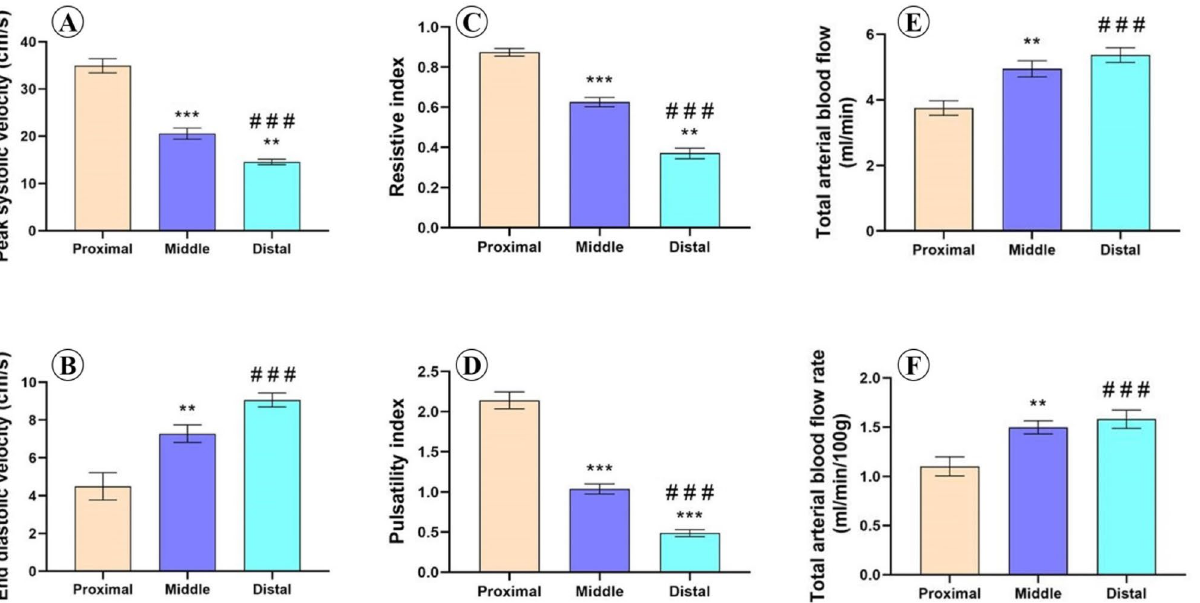
Figure 3. Doppler parameters measured in proximal, middle and distal supratesticular zones in the supratesticular region along the testicular cord. ( A ) Peak systolic velocity (cm/s); ( B ) End diastolic velocity (cm/s); ( C ) Resistive index; ( D ) Pulsatility index; ( E ) Total arterial blood flow (ml/min) and ( F ) Total arterial blood flow rate (ml/min/100 g of testicular tissue). **p < 0.01 and ***p < 0.001 versus proximal zone; ### p < .001 versus middle